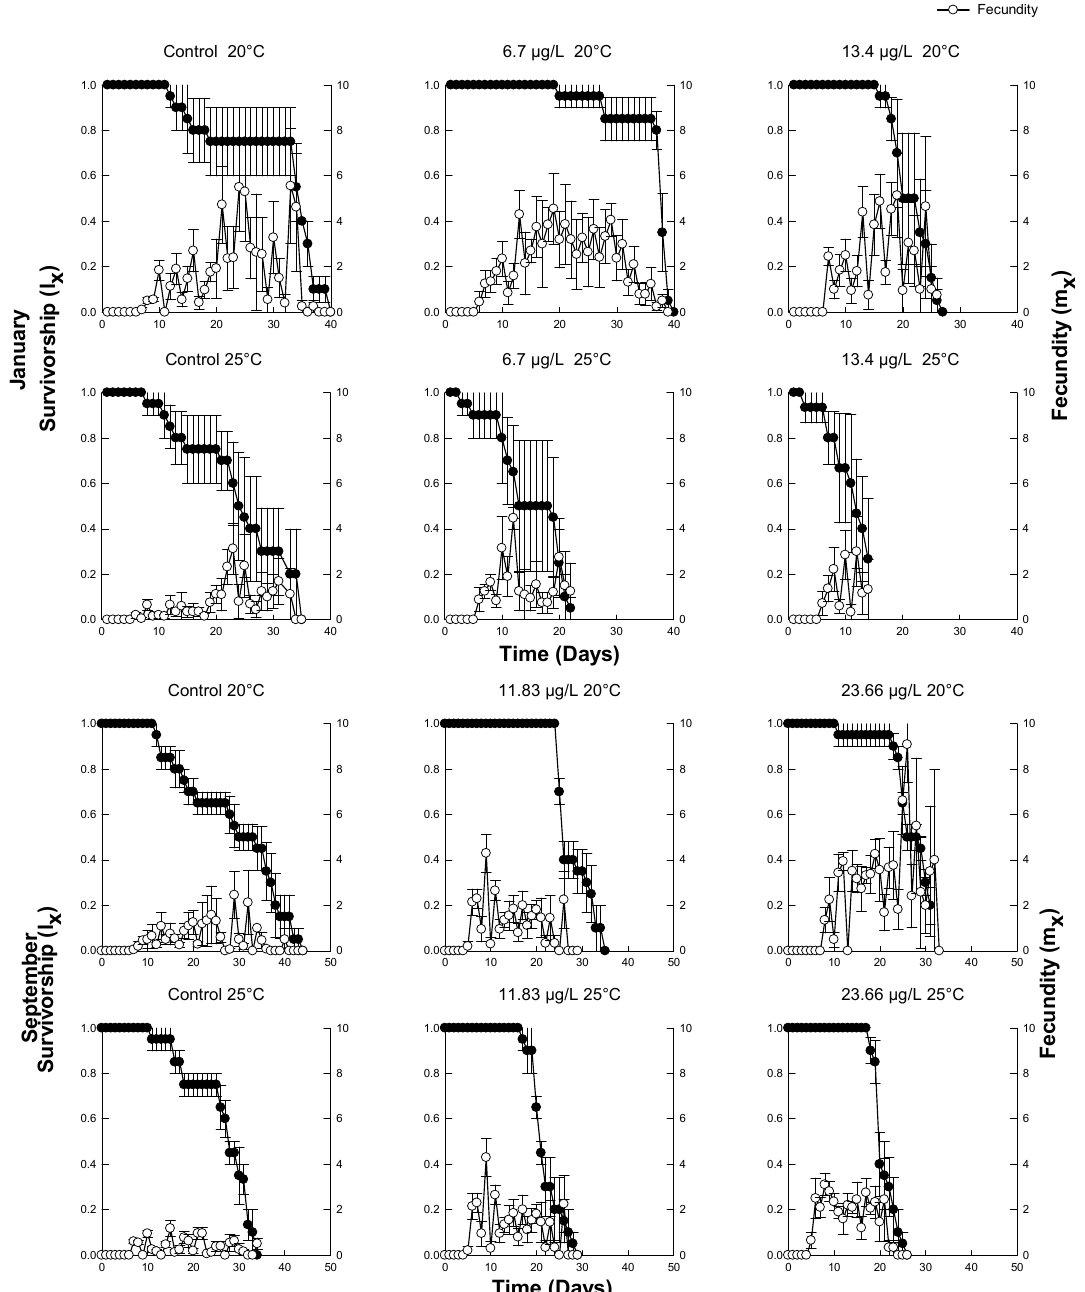
Figure 3. Survivorship and fecundity patterns of Daphnia pulex exposed to cyanobacterial extracts from blooms of Microcystis (January) and Woronichinia (September) at 20 ◦ C and 25 ◦ C. Shown are mean ± SE based on four replicate recordings. At 25 ◦ C, the average life span, life expectancy at birth and generation time of Daphnia pulex exposed to the extracts from Microcystis -dominant blooms collected in January was significantly lower ( p < 0.05, one-way ANOVA) in the presence of either concentration of microcystins, as compared to the controls. For gross and net reproductive rates, a hormetic effect was observed where these parameters were elevated at lower concentrations of microcystins as compared to the control ( p < 0.05, one-way ANOVA). The population growth rates ranged from 0.15 to 0.35 d − 1 and were significantly higher in the presence of the microcystins than in the controls ( p < 0.05, one-way ANOVA) (Figure